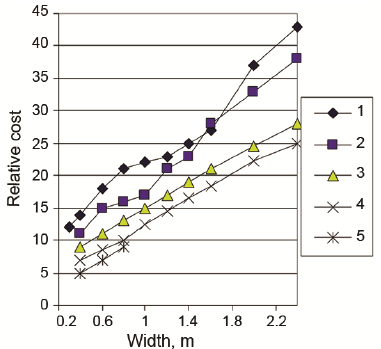
Fig. 6. The cumulative costs of various strip foundations: 1 – typical assembled; 2 – enlarged assembled; 3 – monolithic with RC residual formwork; 4 – monolithic; 5 – monolithic cast in trenches